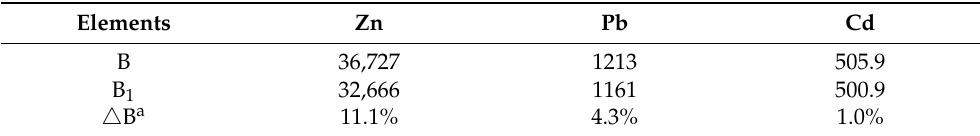
Table 3. Comparison the element content changes in samples A and A 1